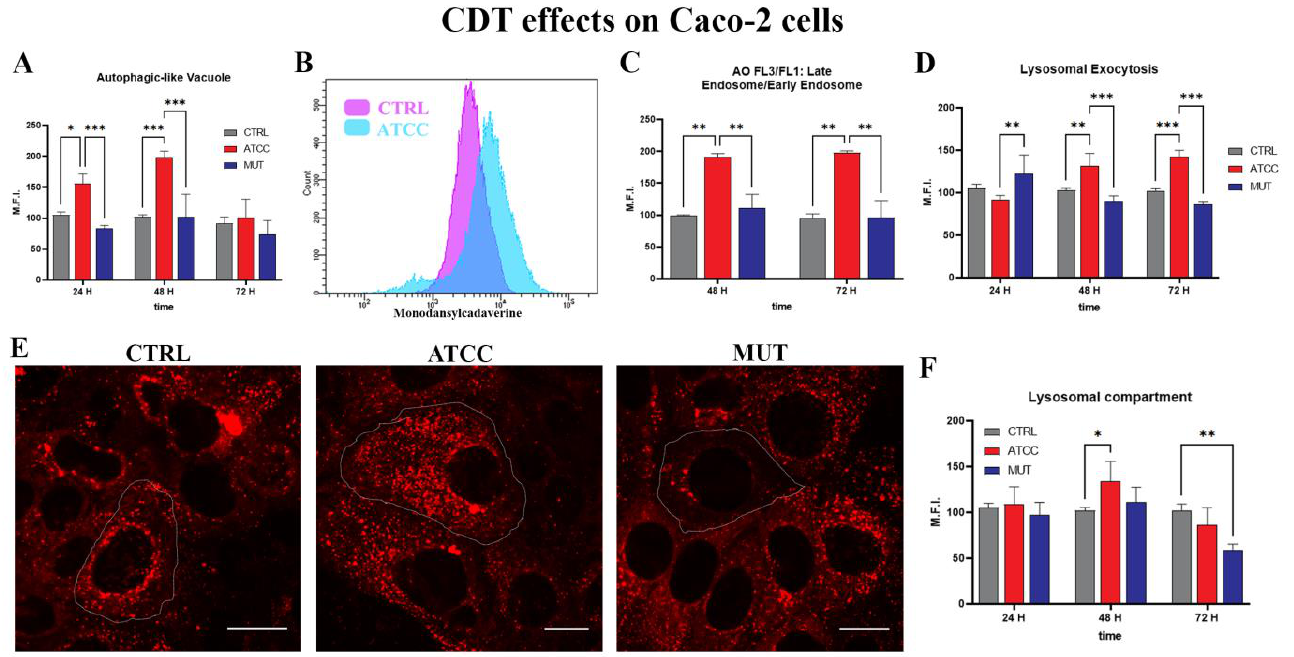
Figure 2. Evaluation of autophagic-like and endo-lysosomal involvement. ( A ) Statistical histogram of MDC MFI from 24 h to 72 h. ( B ) Representative cytometric histogram of the MDC channel for CTRL in violet and ATCC in cyan. ( C ) Statistical histograms of the ratio of the FL3/FL1 AO value at 48 h and 72 h after lysate administration. ( D ) Statistical histograms of the LAMP-1 MFI value at 24 h, 48 h, and 72 h after lysate administration. ( E ) Single confocal optical sections show the LTDR (red) for lysosome tracking at 48 h for the untreated-control cells (CTRL), cells treated by ATCC C. jejuni lysates (ATCC), and mutant cdtA C. jejuni (MUT). Bars: 20 µ m. ( F ) Statistical histograms of the LTDR MFI value from 24 h to 72 h of the lysate treated Caco-2 cells. Two-way ANOVA with Bonferroni’s multiple comparison test. The asterisk denotes a statistically significant difference (* = p < 0.05, ** = p < 0.01, *** = p <